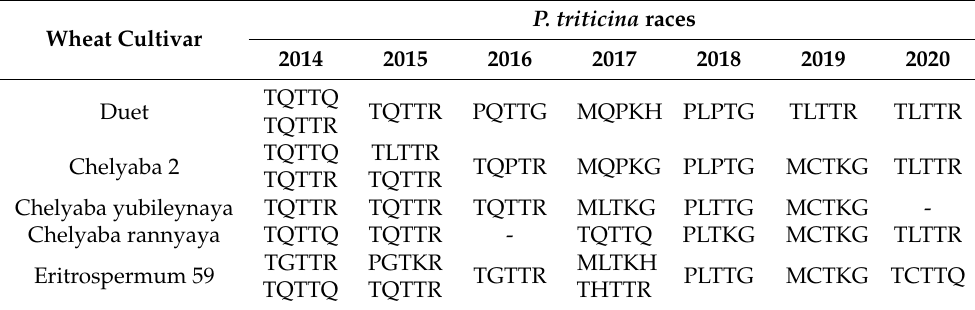
Table 3. Races of P. triticina identified on widely grown spring wheat cultivars in Chelyabinsk region in 2014–2020. Wheat Cultivar